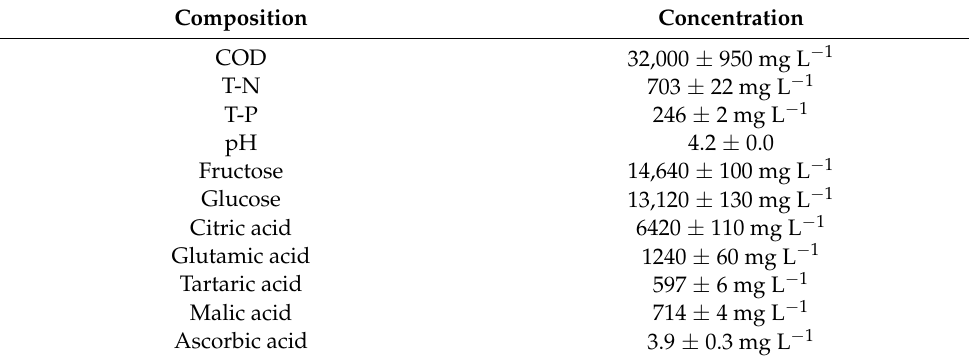
Table 1. Chemical composition of raw sample of the spent tomato byproducts (STB). All analyses were performed in